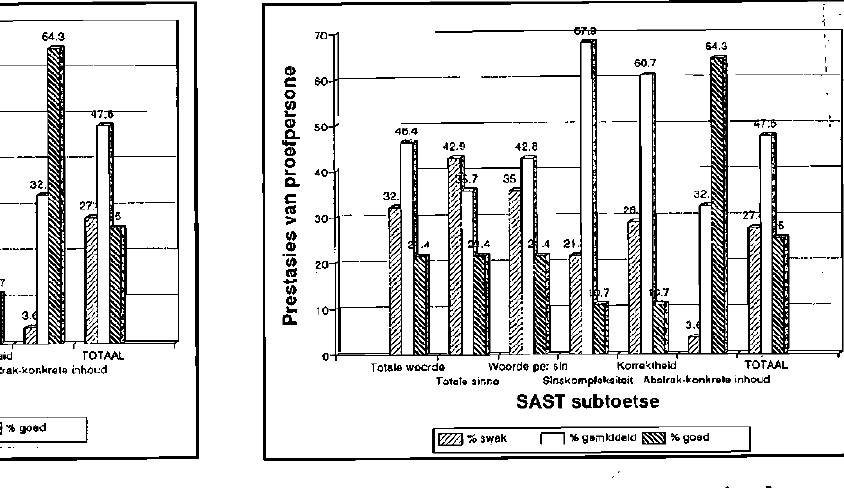
FIGUUR 2: Swak, gemiddelde en goeie prestasies van proefpersone in geskrewe taal